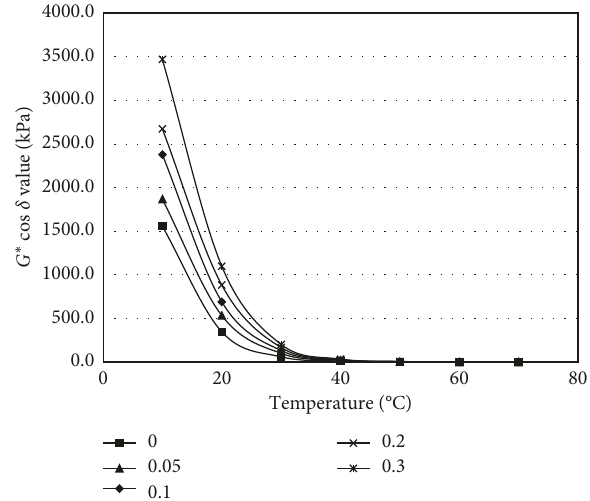
Figure 11: mastic (1.78Hz).